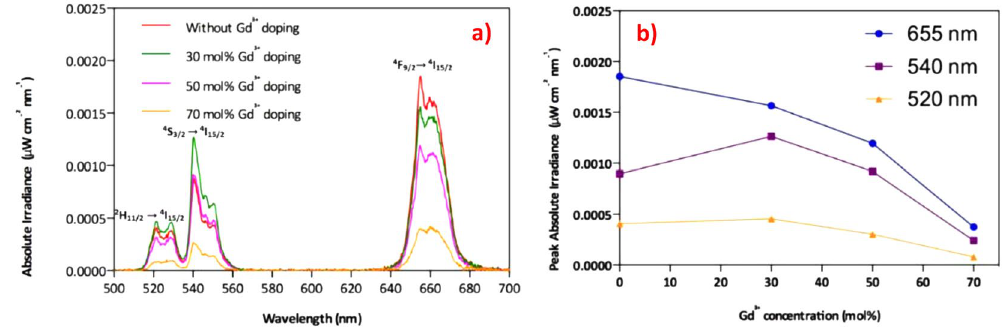
Figure 8. ( a ) demonstrates the absolute irradiance of UC photoluminescence emission spectra of the resulting NaYF 4 :Yb 3 + , Er 3 + when tuning the Gd 3 + dopant molar concentration from 0 to 70 mol% upon 980 nm laser excitation. ( b ) shows the UC luminescence emission intensity at 656 nm, 540 nm, and 520 nm versus different Gd 3 + doping concentration (0, 30 mol%, 50 mol%, and 70